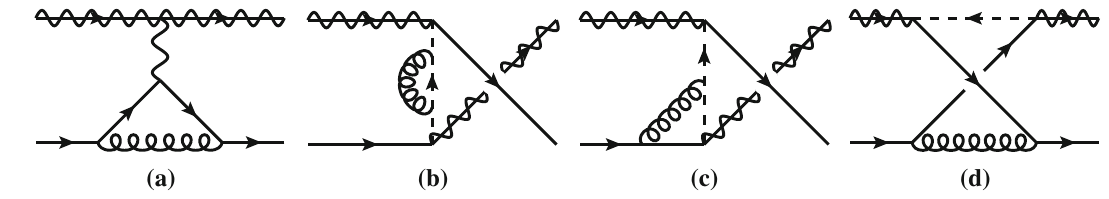
Fig. 3 Representative one-loop Feynman diagrams for DM-quark scattering, for the s -channel ( a ) and t -channel ( b – d )